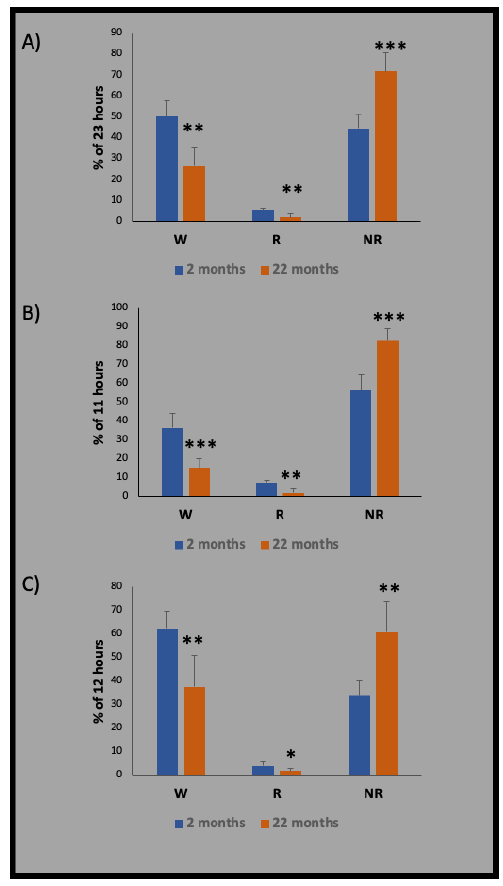
Figure 3. Effects of age on sleep, as investigated by electroencephalography/electromyography recordings on 2- and 22-month-old male Wistar rats (blue and orange column, respectively). In aged rats, there was a markedly increased sleep period and reduced wakefulness in both light (resting phase) and dark (active phase) periods. Recordings were performed over: ( A ) full-day period (ZT1– ZT23), ( B ) light phase (ZT1–ZT11), and ( C ) dark phase (ZT12–23). Data are expressed as mean ± SD ( n = 5). * p < 0.05, ** p < 0.01, and *** p < 0.0001, with unpaired two-tailed t -test. The recording procedure was described in our previous study [26].